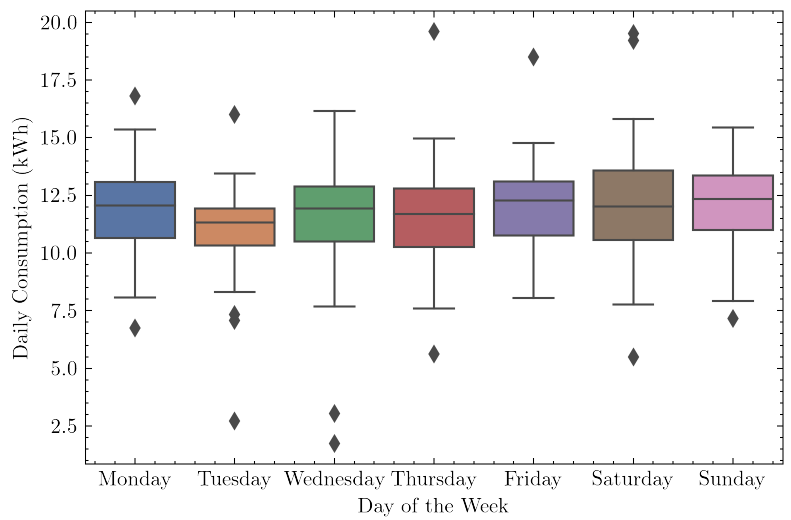
Figure 4. Box plot of the total consumption per day of the week for one of the households.